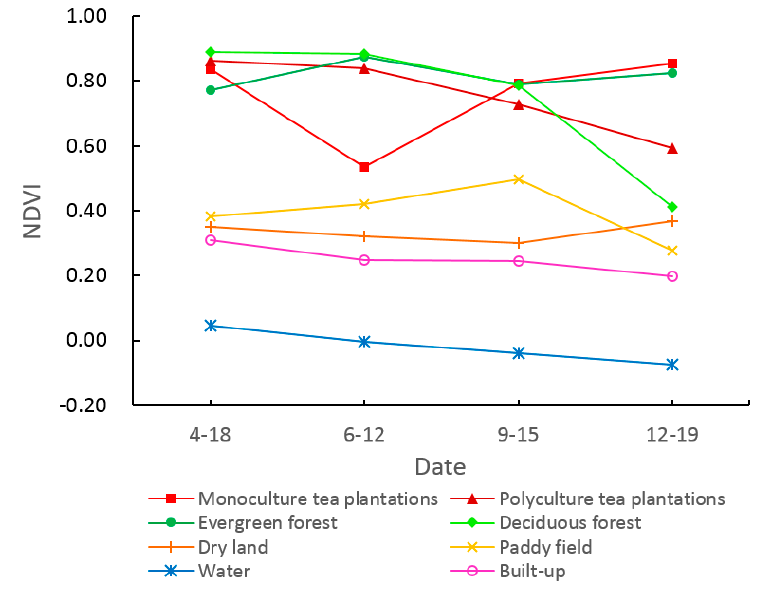
Figure 7. NDVI values for the eight LULC types on the four image dates. Table 1. Feature parameters extracted from the four Sentinel-2 images and topographic